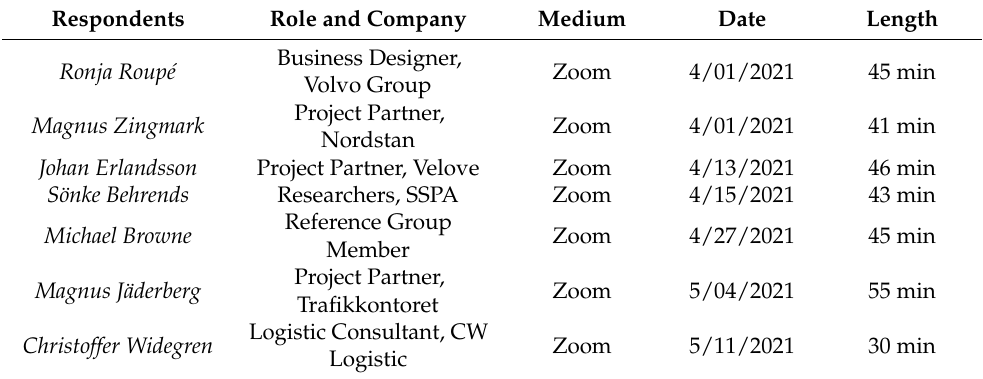
Table 4. Interviews